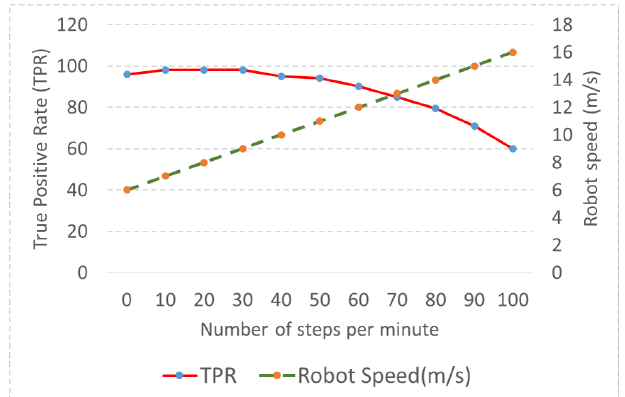
Figure 12. Direction of motion of mobile robot and human being during experiment The reason for the decreased TPR as observed is that that with high walking speed human move away from sensors so quickly that feature values extracted from the data frame are not able to detect human